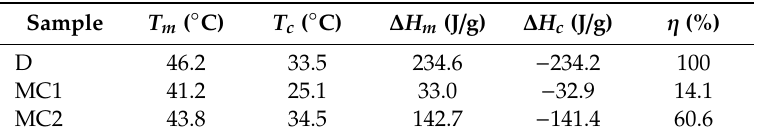
Table 3. Main results of the DSC tests on the bulk (D) and microencapsulated (MC1 and MC2) docosane. The table reports data of the phase change temperatures and enthalpies, as well as the encapsulation e ffi